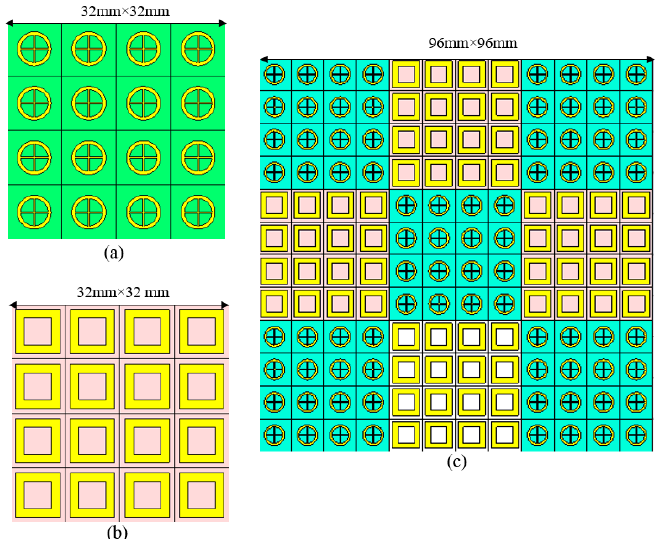
Figure 3. AMC unit cell arrangements in two different chessboards. ( a ) 4 × 4 tiles are arranged with AMC1 unit cell, and the block array size is 32 mm × 32 mm. ( b ) 4 × 4 tiles are arranged with AMC2 unit cell, and the block array size is 32 mm × 32 mm. ( c ) Two AMC unit cells are arranged like a chessboard, an array block size of 96 mm × 96 mm.